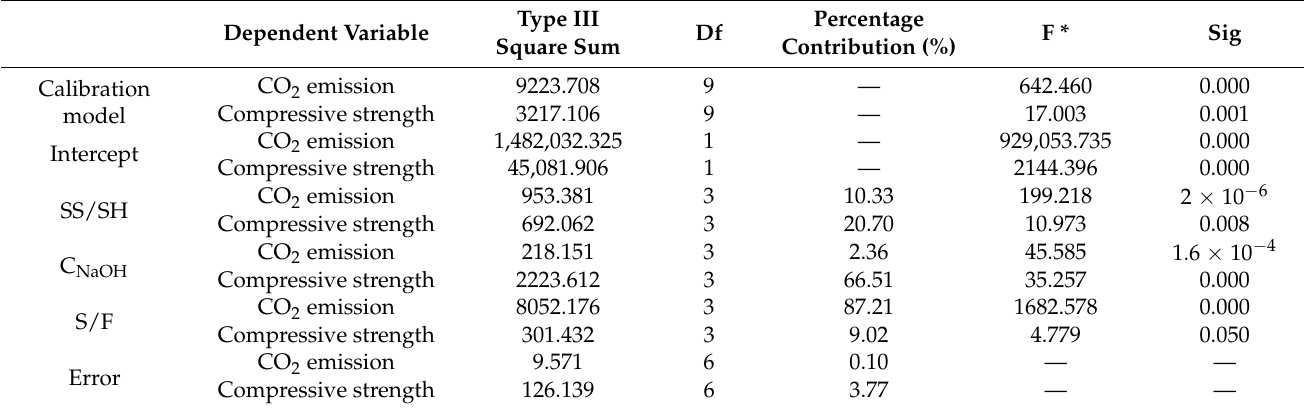
Table 5. Test of the inter-subjectivity effect.